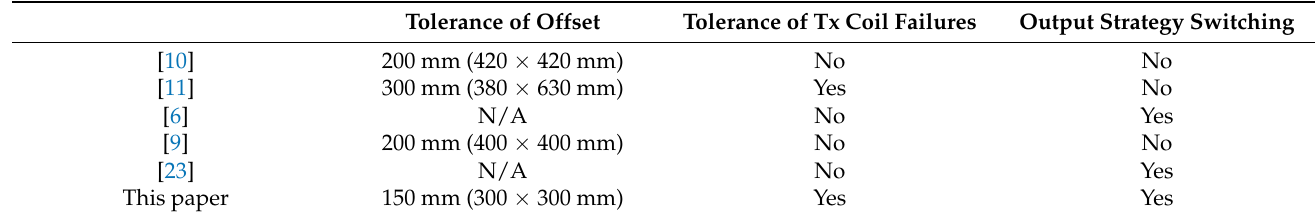
Table 2. Comparison with different WPT